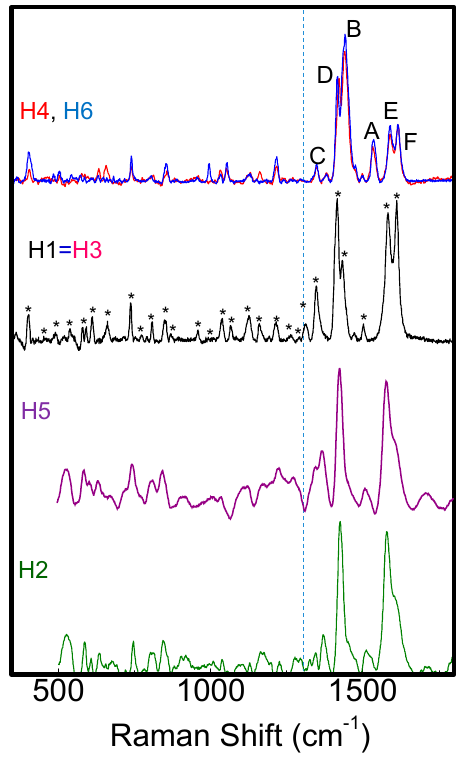
Figure 7. Raman spectra of H1–H6 samples.